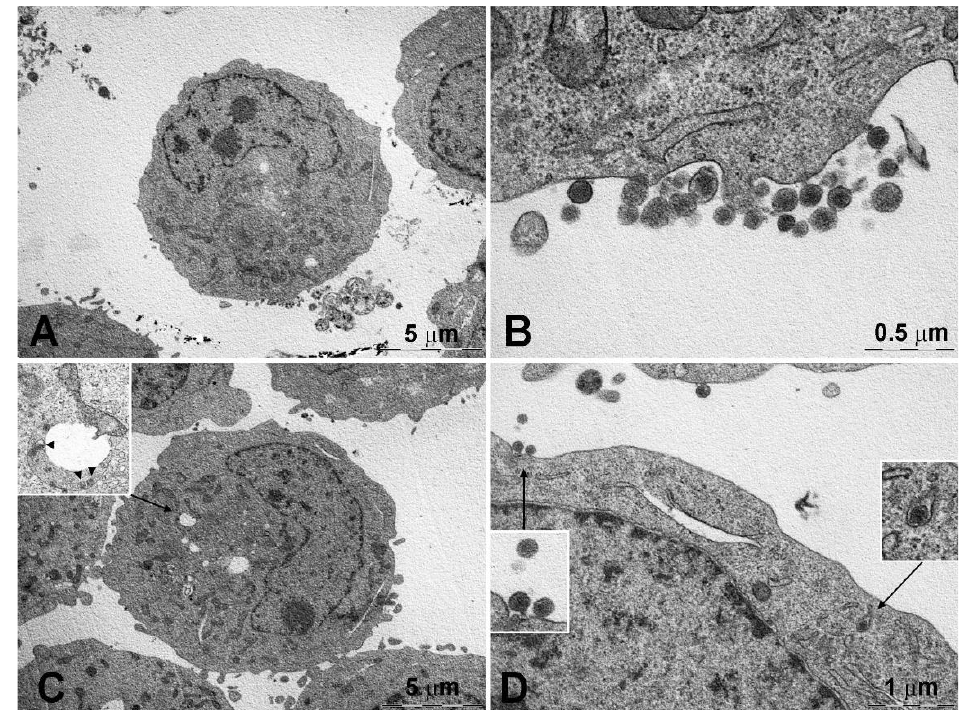
Figure 6. K562/DOXO cells after 15-min incubation with peroxidase-containing liposomes. ( A ) The cells show a normal ultrastructure and one of them (center) shows a cluster of membrane-bound, electron-dense particles, identified as liposomes, opposed to the plasma membrane. ( B ) Detail of the liposomes shown in ( A ), some of which are attached to the plasma membrane; mitochondria still show a normal appearance. ( C ) Cells showing moderate cytoplasmic vacuolation (see insert) and electron-dense particles corresponding to liposomes (arrowheads). ( D ) Detail of the cell in ( C ).